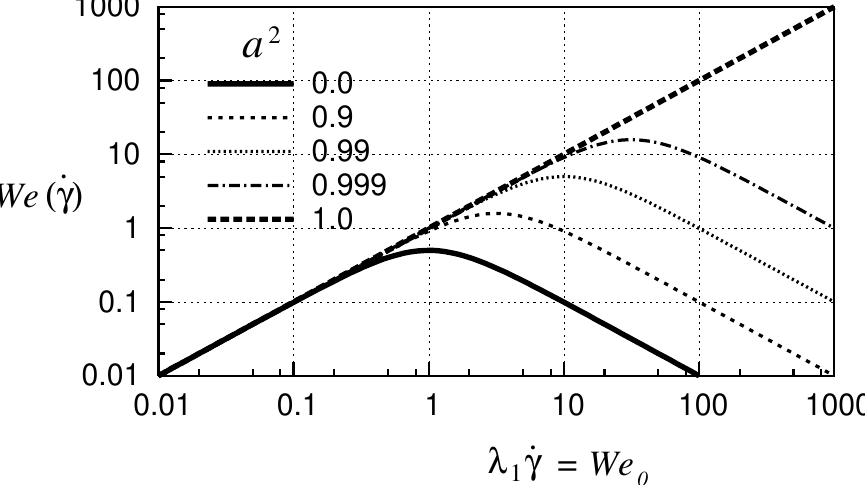
Figure 7. Effective (shear-thinning) Weissenberg number as a function of the shear rate. In terms of the ratio between the “shear-dependent” Weissenberg number We ( ˙ γ ) and its constant viscosity counterpart We it is even more obvious, as observed in Figure 8. 0